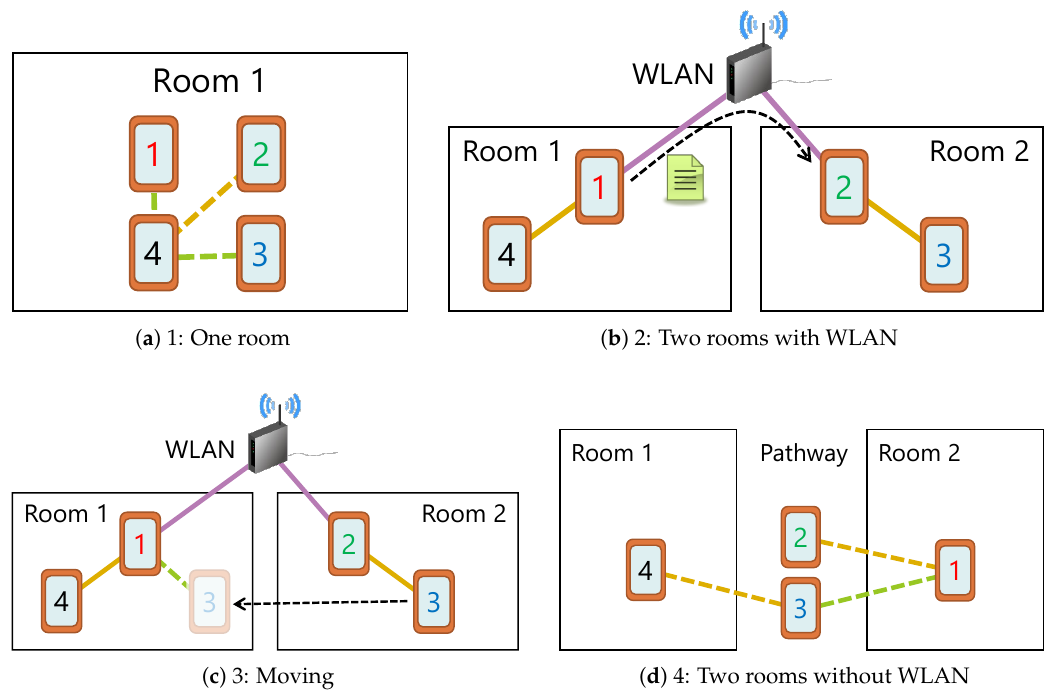
Figure 8. Operation verification scenarios. Finding devices in the remote room was impossible by Wi-Fi Direct or Bluetooth, but devices in the pathway could discover devices in each